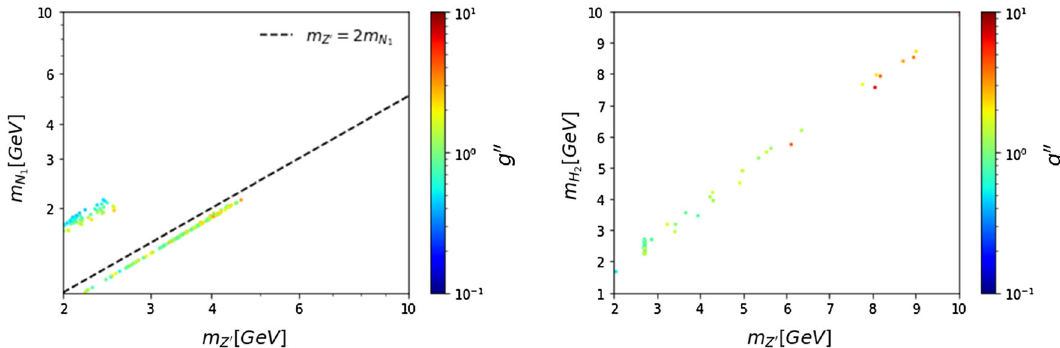
Fig. 5 Allowed regions of parameter space satisfying the observed DM relic density constraint. Left: The DM candidate is N 1 and right: the DM candidate is H